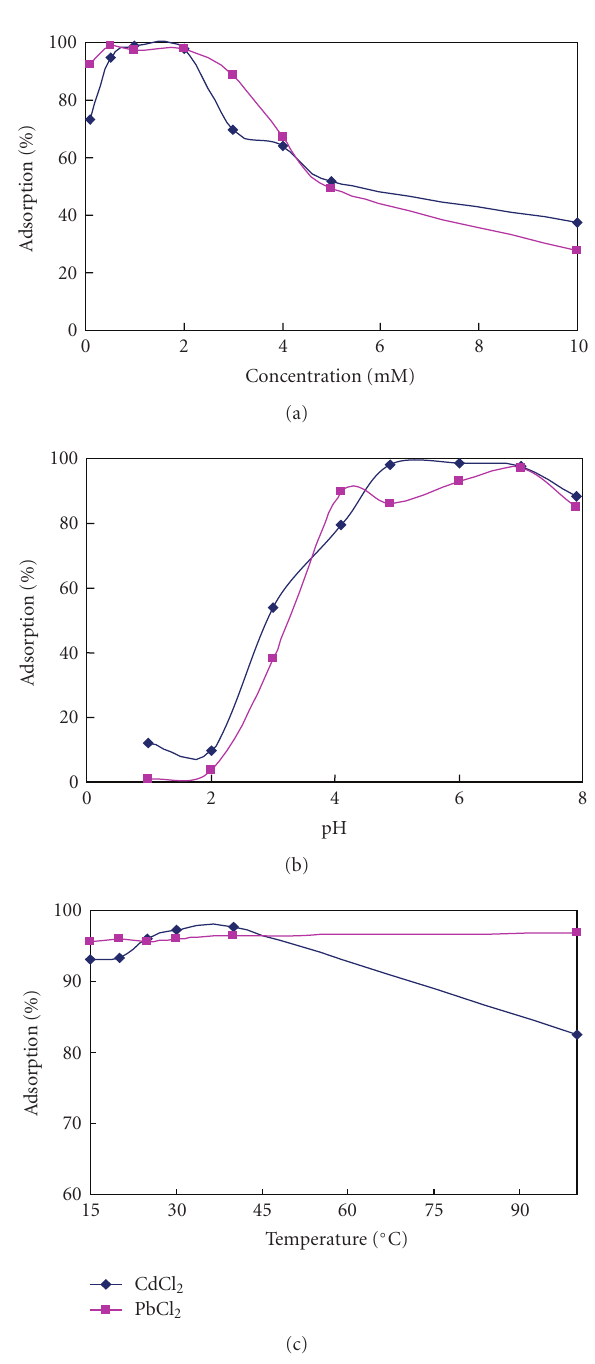
Figure 1: Absorption of heavy metals with squid melanin: (a) The influence of metal concentration on adsorption performance; (b) the influence of pH on biosorption performance; (c) the influence of temperature on biosorption